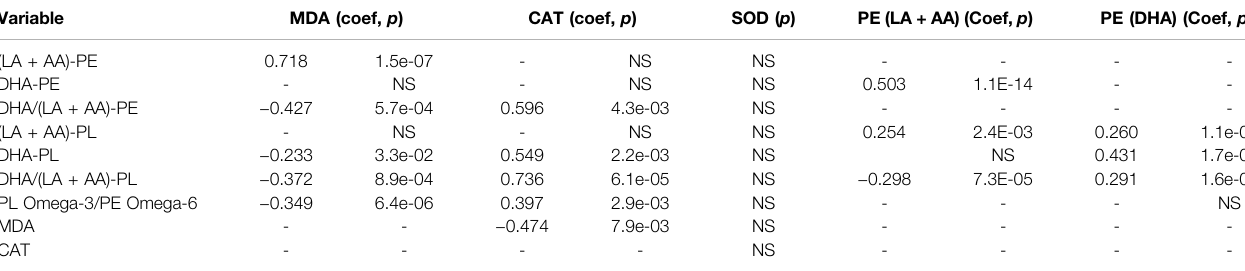
TABLE 2 | Relationship between key serological indices.